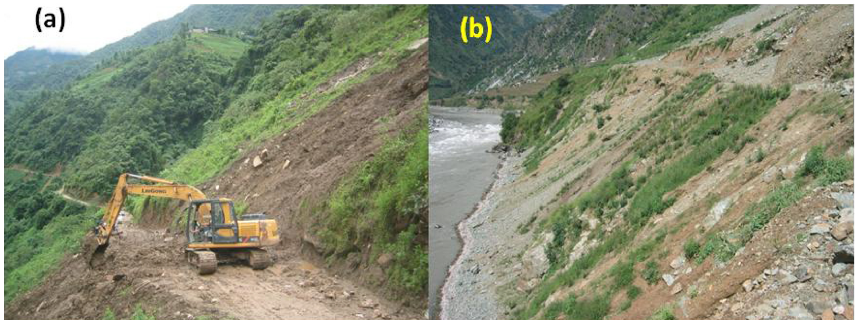
Figure 7. (a) A section of the FG2 road several kilometers north of Fugong that was temporarily closed by a landslide; and (b) secondary road to a small mountain village near Daxingdi (not included in our landslide survey) that was abandoned during construction because of excessive